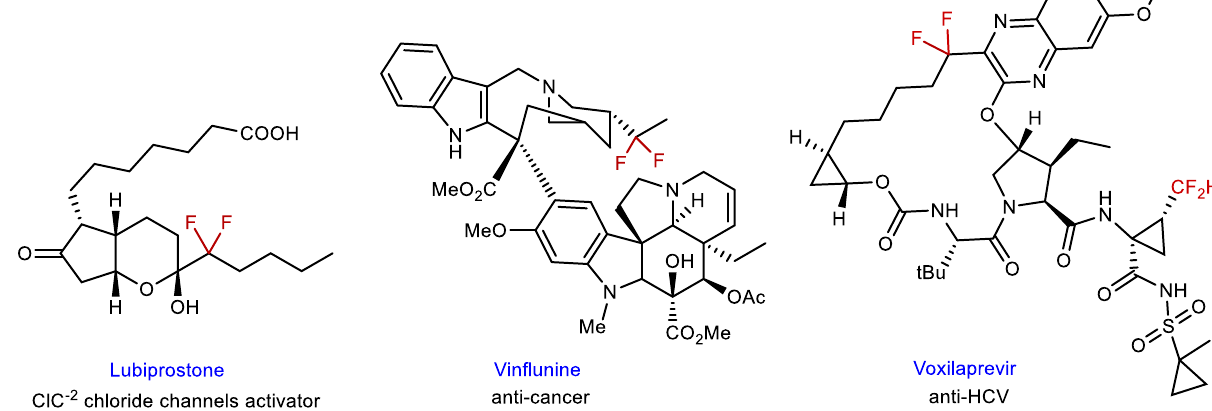
Fig. 1 Chiral molecules containing a di fl uoroalkyl substituent. Examples of pharmaceuticals containing the di fl uoroalkylated chiral